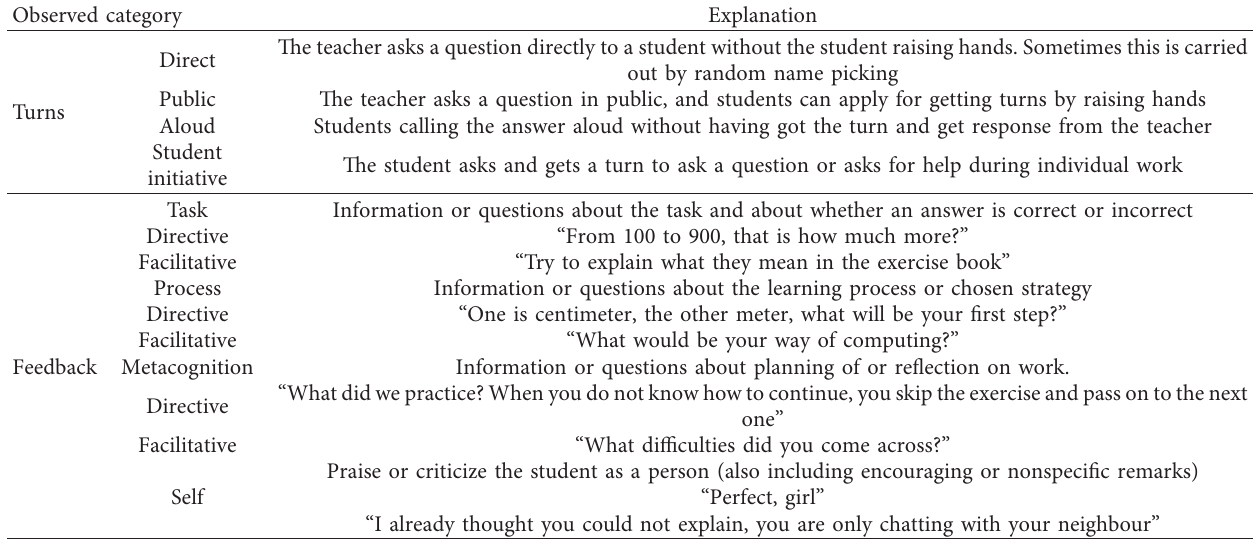
Table 1: Observed turns and feedback categories with